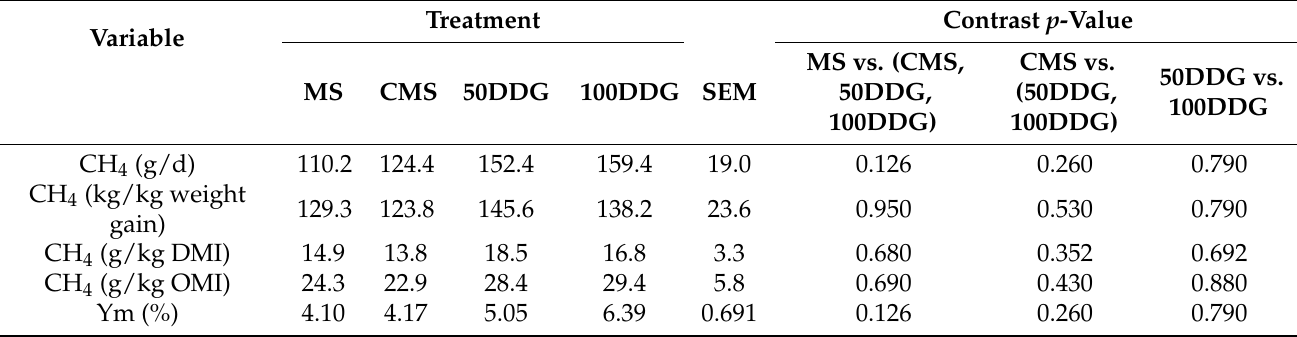
Table 8. Enteric CH 4 emissions of young Nellore bulls fed with mineral supplementation (MS); conventional multiple supplement (energy/protein) with cottonseed meal and citrus pulp (CMS); supplement with 50% of CMS protein source replaced by DDG (50DDG); and supplement with 100% of CMS protein source replaced by DDG (100DDG), grazing Marandu grass during the wet